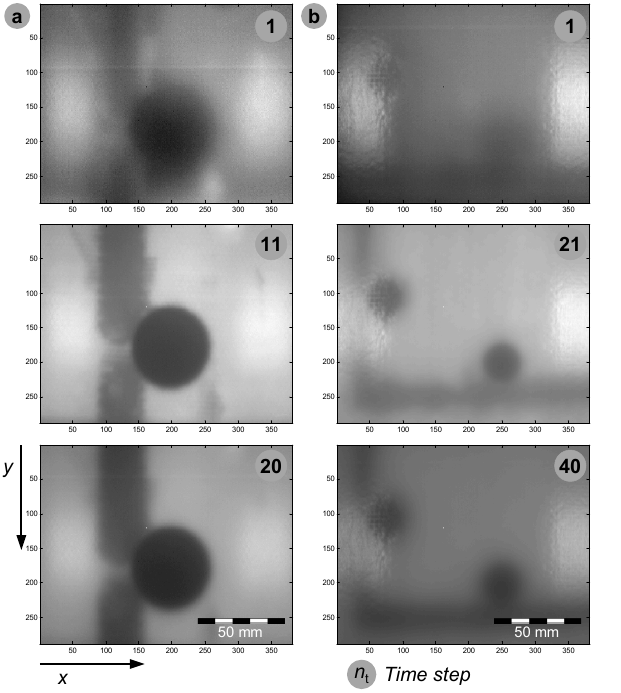
Figure 5. First 6 EOFs of the GFRP